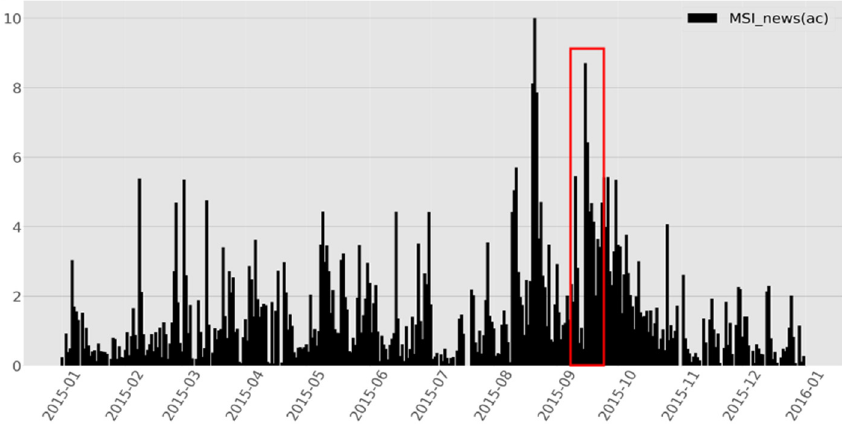
Figure 3. Keywords related to provocation-based results ( MSI_news ac ).